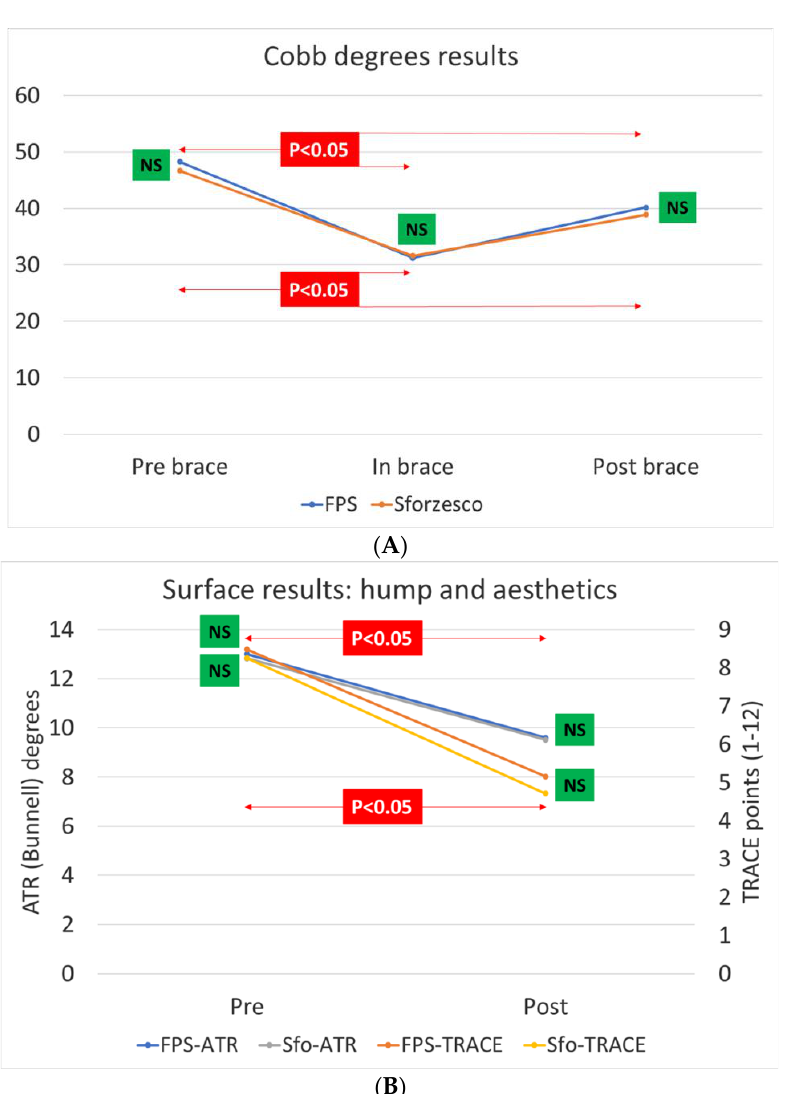
Figure 3. Main results pf this study. We did not find differences at any time stage for the primary Cobb degree outcome ( A ) or at the start and the end for the secondary angle of trunk rotation (ATR degrees) and aesthetics (TRACE points) outcomes ( B